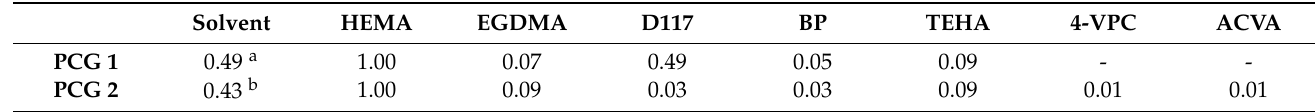
Table 1. Molar ratios of HEMA crosslinked hydrogel film mixtures.